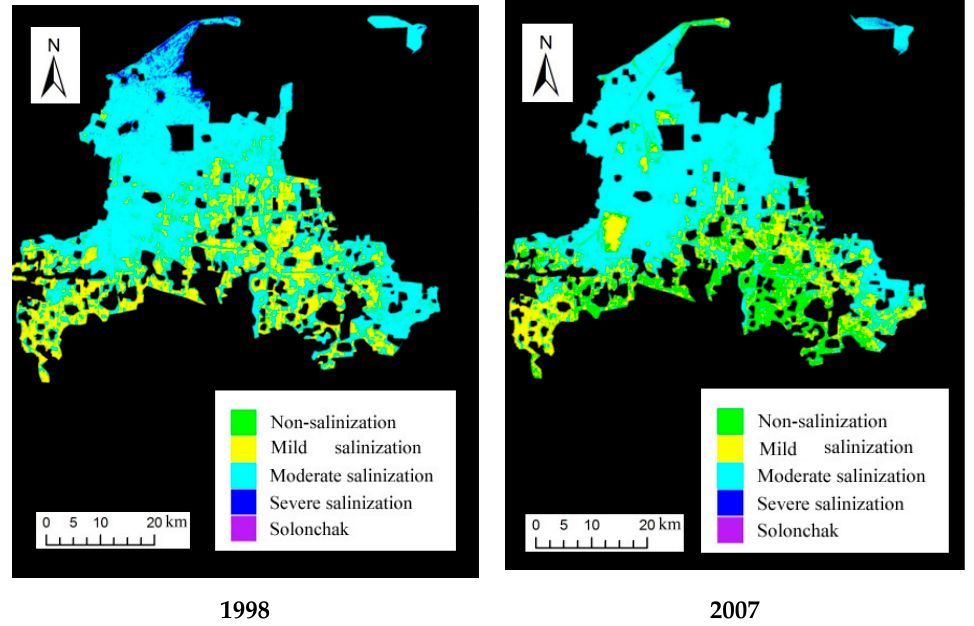
Figure 6. Soil Salinization Distribution of OLI Image in Northern Shouguang in 1998 and 2007.